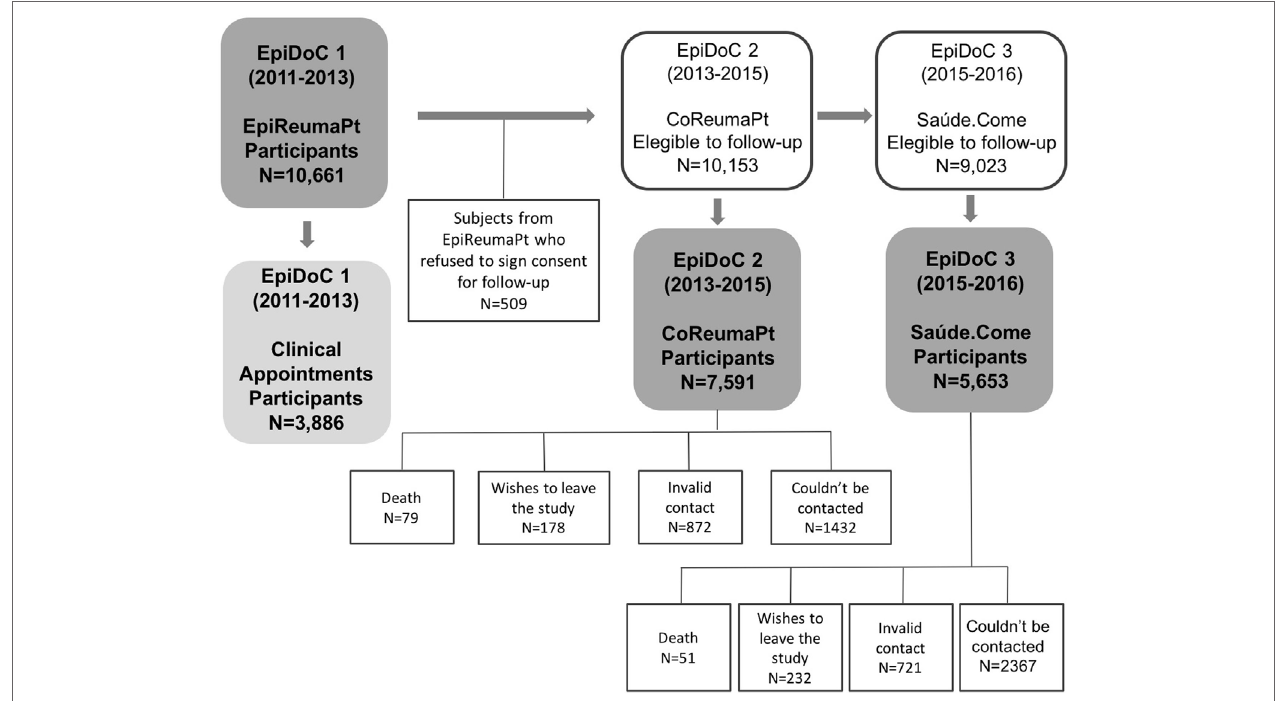
FigUre 1 | Flowchart of the EpiDoC cohort (consisting of three